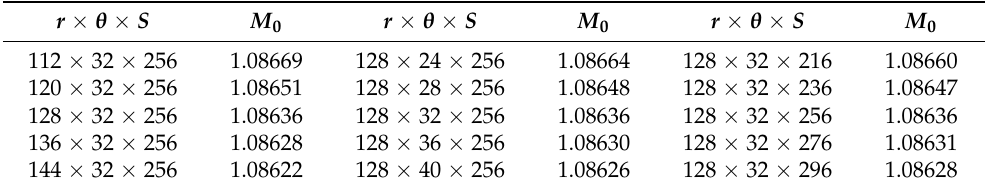
Table 1. Values of M 0 when changing grid points.